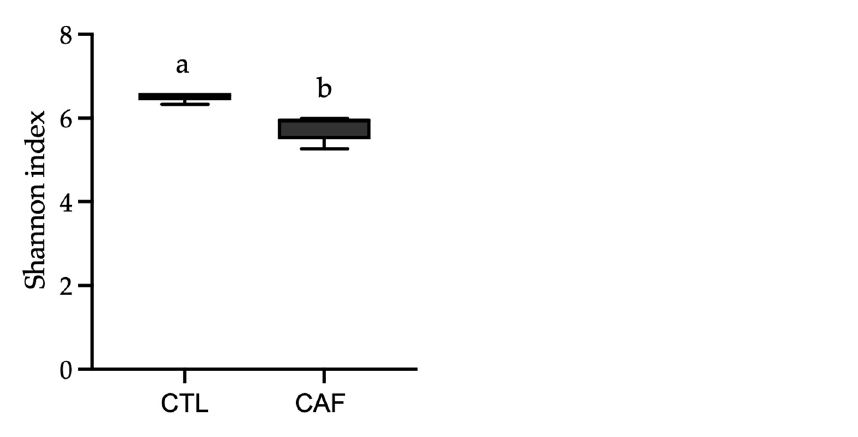
Figure 2. Gut dysbiosis in male Wistar rats fed cafeteria diet evaluated using the Shannon index. The results are expressed as mean ± standard deviation ( n = 5). Statistical analysis was performed using Student’s t test for two independent samples. Mean values with different letters (a,b) show significant differences ( p < 0.05). CTL: control group; CAF: cafeteria group.